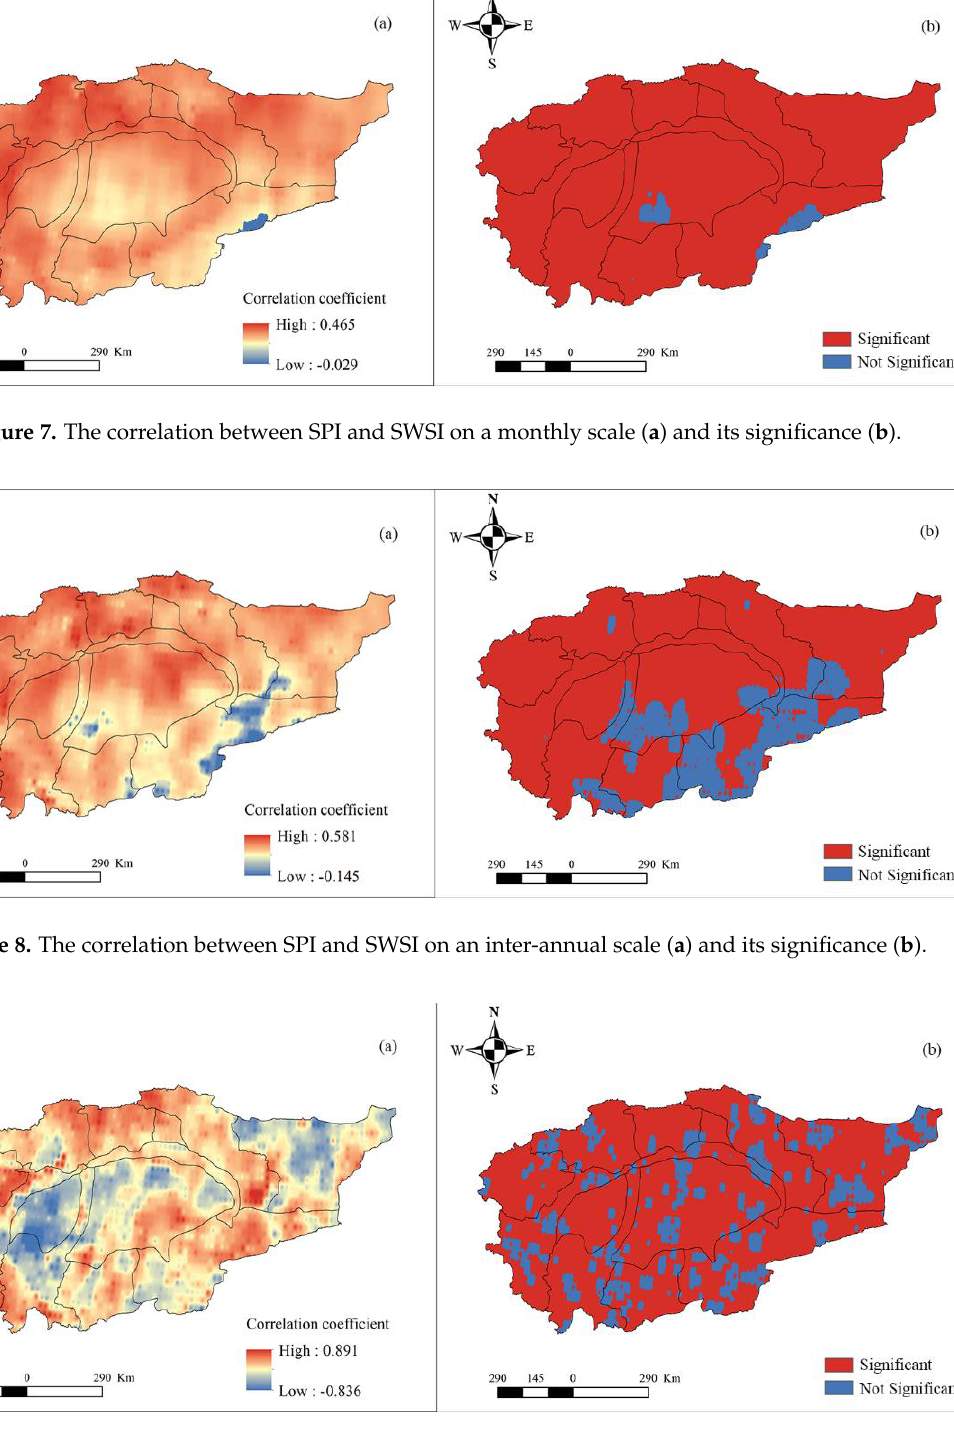
Figure 9. The correlation between SPI and SWSI on an inter-decadal scale ( a ) and its significance ( b ).